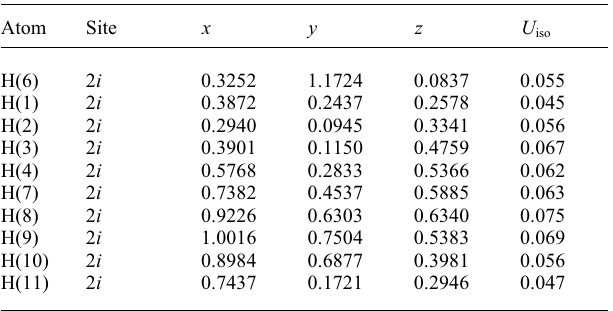
Table 3. Atomic coordinates and displacement parameters (in Å 2 )